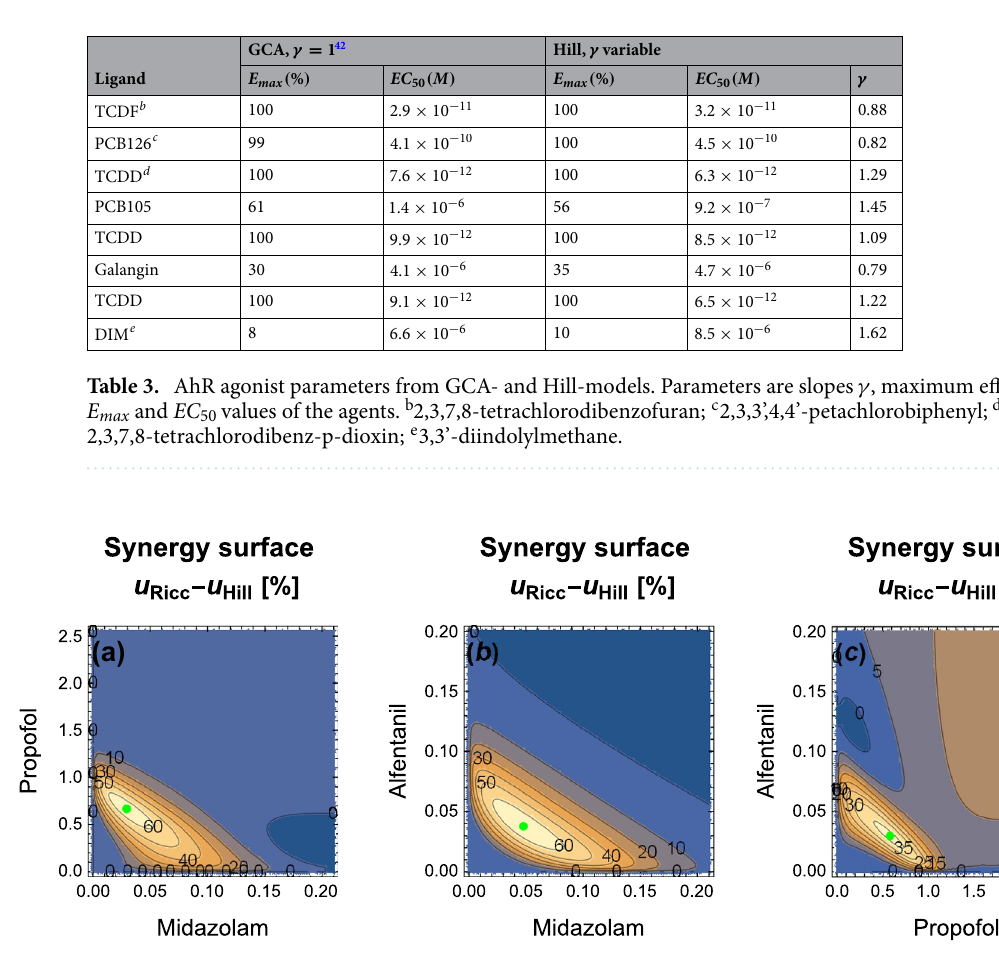
Figure 2. Synergy surfaces for binary mixtures of anesthetics, based on u Ricc of Eq. (35), with parameters δ ab , δαβ and δ m ab from Table 1. Doses in [mg/kg]. Green dots denote dose combinations leading to peak synergistic